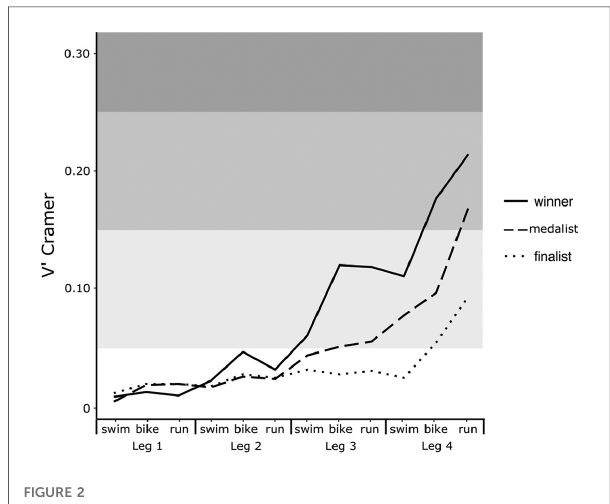
FIGURE 2 Evolution of the magnitude of V ’ Cramer calculated for each fi nal